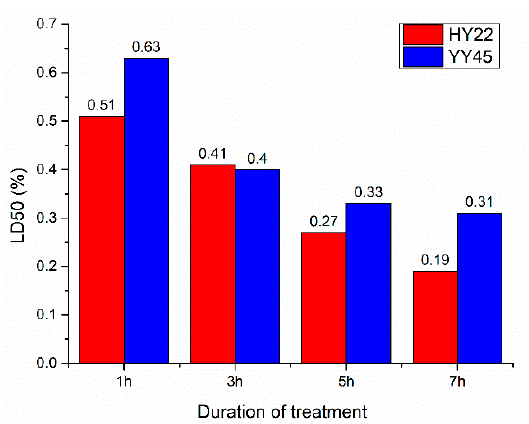
Figure 2. Median lethal dose (LD50) values of HY22 and YY45 with different EMS treatments.